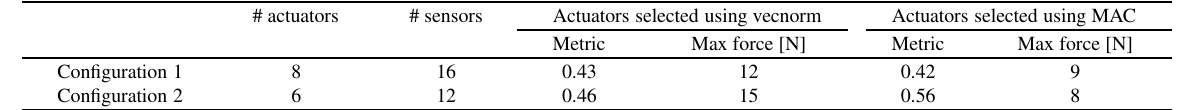
Table 2 Mean of performance metrics for configurations 1 and 2 using FxLMS